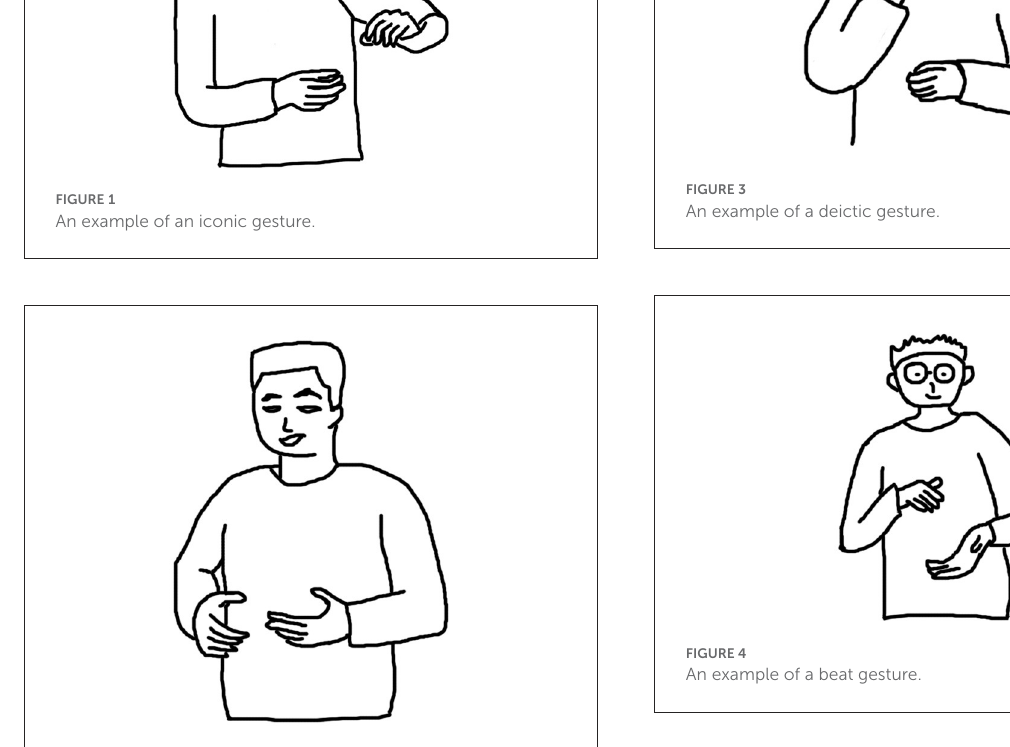
FIGURE2 An example of a metaphoric gesture.